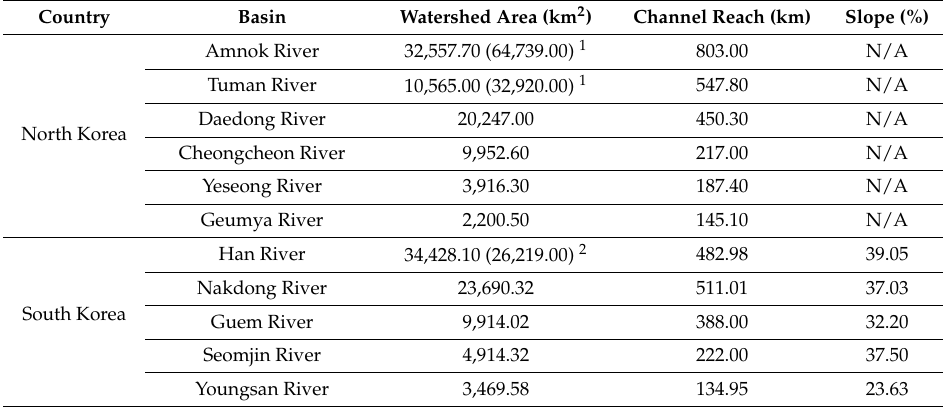
Table 1. Characteristics of major river basins in the Korean